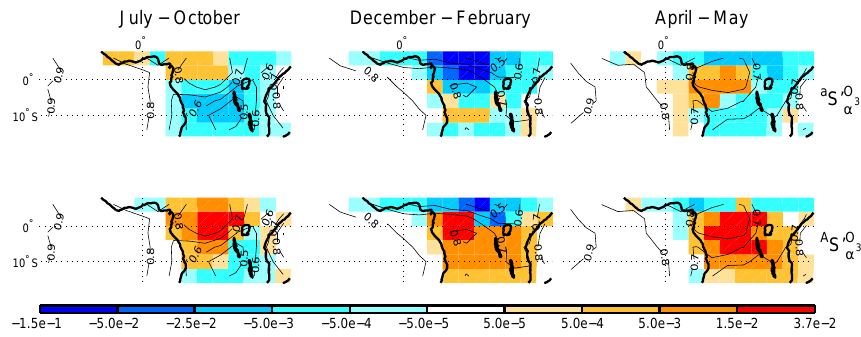
Fig. 8. Seasonal variations in the adjoint sensitivity of Atlantic (top row) and African (bottom row) ozone to the NO x recycling from ING 0 photooxidation ( α ) summed from the surface to p l =500 mbar ( R 1 S O 3 α = P p>p the loss of isoprene peroxy radicals through reaction with HO 2 and the loss of isoprene peroxy radicals through reaction with HO 2 and